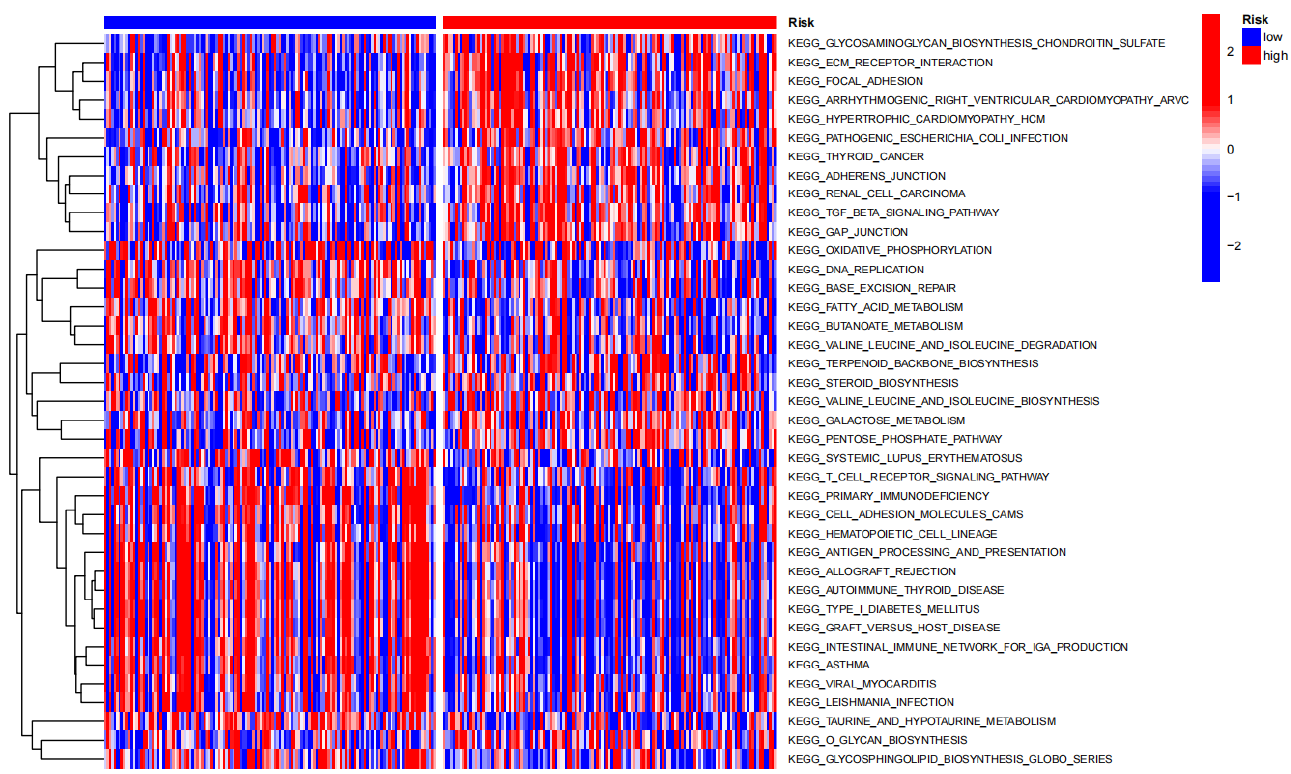
Figure 7. GSVA enrichment analysis for the different risk groups. The heatmap depicts the expression profiles of the KEGG pathways between the high-risk group and the low-risk group.